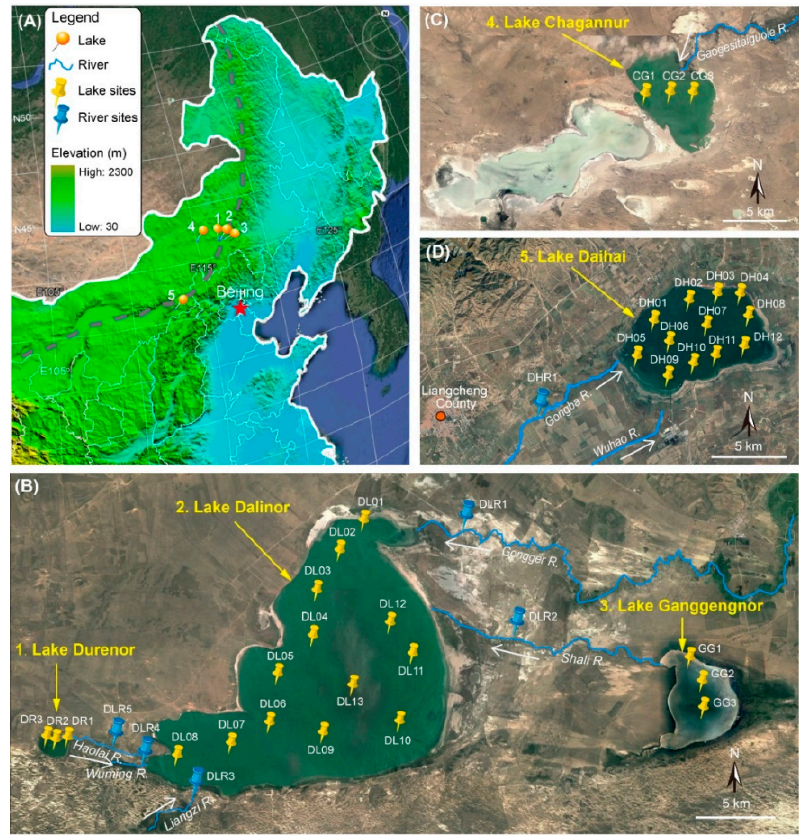
Figure 1. Satellite images of the study sites in the Inner Mongolian Plateau of China (from http: //www.maps.google.com). ( A ) Northeast China, showing the location of the five lakes. Grey dashed line shows the current northern limit of the East Asian summer monsoon. ( B ) Lake Dalinor basin showing the connected lakes and the 19 sampling sites in the three lakes, and 5 sampling sites among the five rivers. ( C ) Lake Chagannur showing three sampling sites. ( D ) Lake Daihai showing 12 sampling sites in the lake, and 1 sampling site in one of its upstream rivers. White arrows show the waterflow directions of the